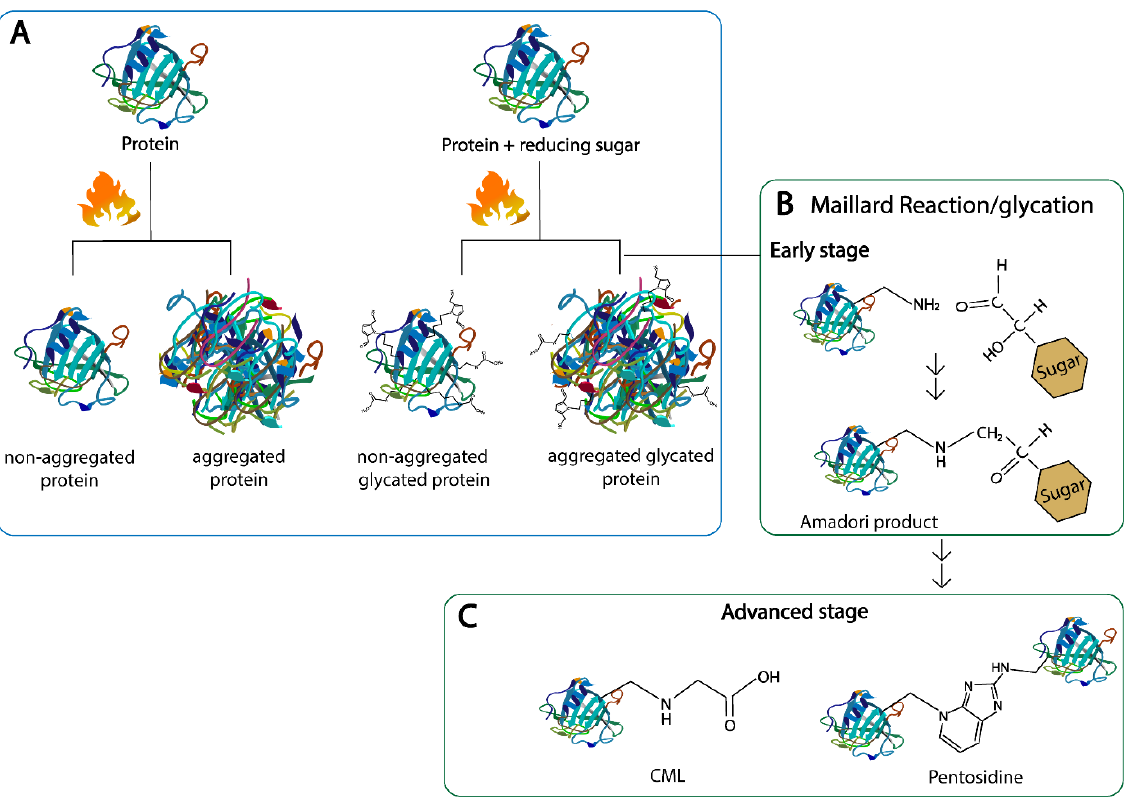
Figure 1. Structural changes in proteins upon heating with and without reducing sugars. ( A ): pro- Structural changes in proteins upon heating with and without reducing tein aggregation, ( B ): early Maillard reaction, ( C ): advanced stage of the Maillard reaction. N ɛ -car- boxymethyl lysine (CML) and pentosidine are shown as representatives for linear and cross-linking of heterocyclic advanced glycation end products, respectively.